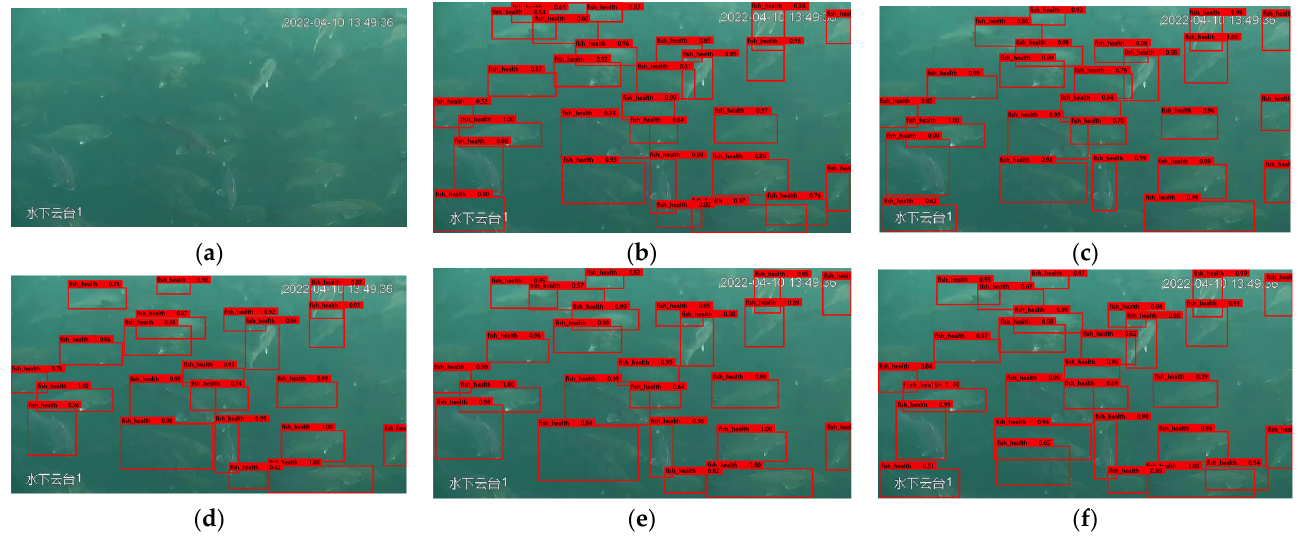
Figure 8. Real-time detection of fish skin disease on Korean rockfish in deep-sea cages. ( a ) input ( b ) YOLOv4 ( c ) MobileNet v1-YOLOv4; ( d ) MobileNet v2-YOLOv4 ( e ) MobileNet v3-YOLOv4 ( f ) MobileNet v3-GELU-YOLOv4. Table 2. Table of network model